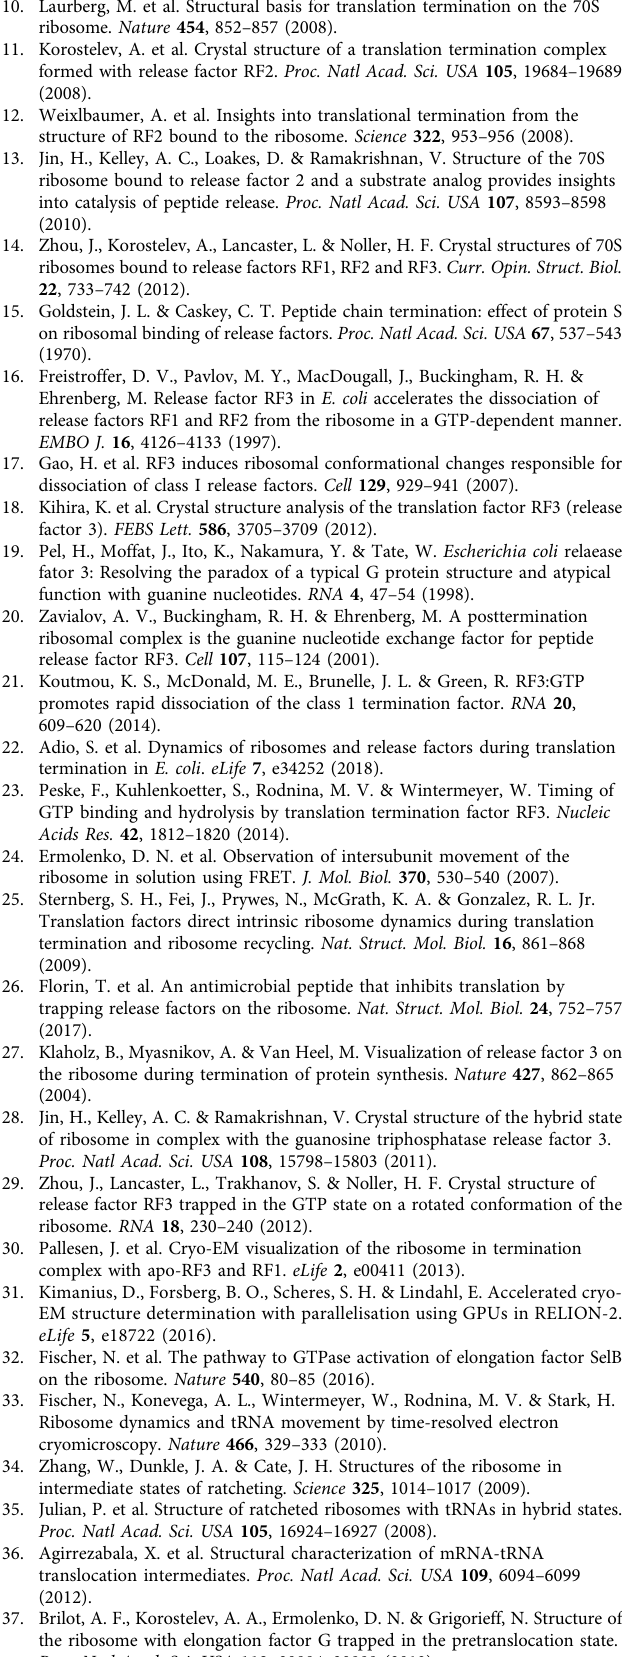
Figure preparation . All fi gures showing electron densities and atomic models were generated using UCSF Chimera 71 and PyMol Molecular Graphics Systems (Ver- sion 1.8